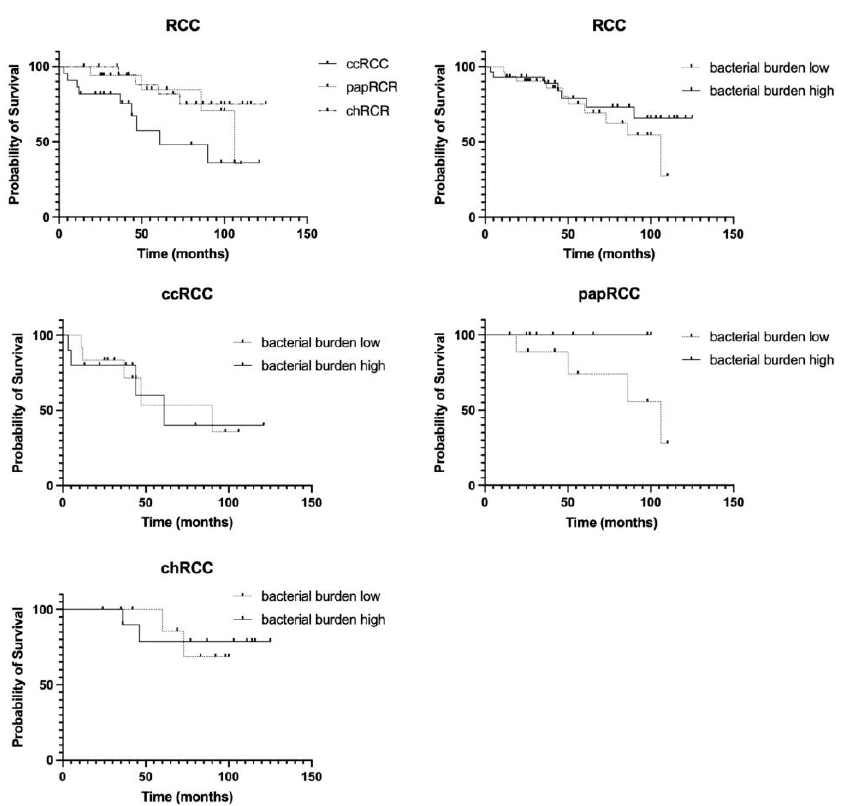
Figure 7. Prognostic significance of the histological type of the tumor in general, as well as the total bacterial load, in RCC.